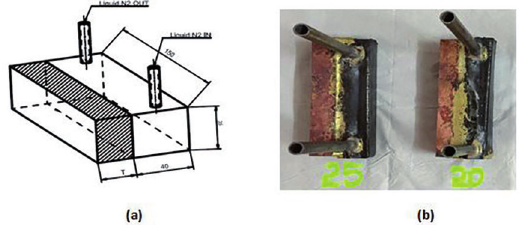
Figure 3: (a), (b) - Brazed copper chill with steel hollow block for passing liquid nitrogen. To study the tensile behaviour and to determine the ultimate tensile strength of the matrix composites, specimens were prepared and tested as per ASTM E8 / E8M-15a [23] standard as shown in Figure 4. The specimens were machined using wire cutting. Tensile test were performed using Universal Testing Machine model: TUE-C –400.